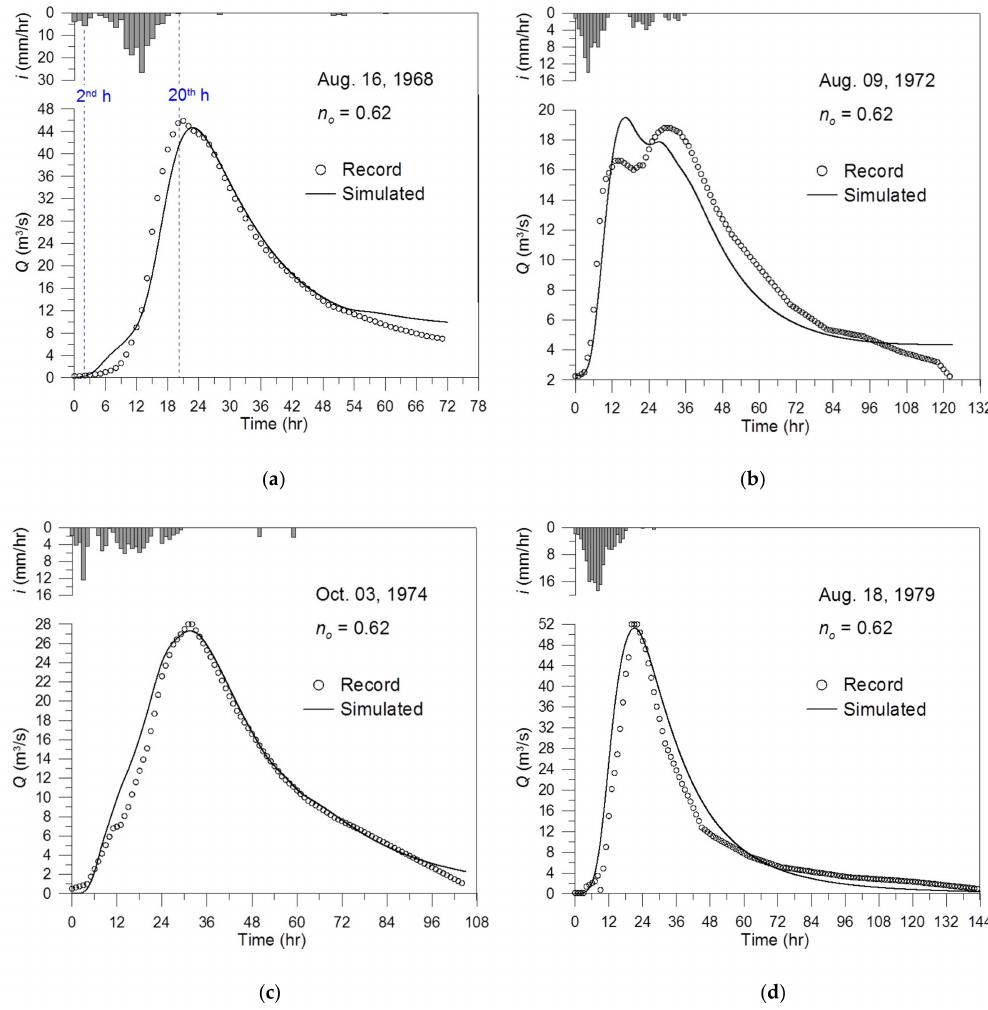
Figure 5. Simulated flow hydrographs of four storm events that occurred in the Komarovsky watershed, ( a ) 16 August 1968, ( b ) 9 August 1972, ( c ) 3 October 1974, ( d ) 18 August